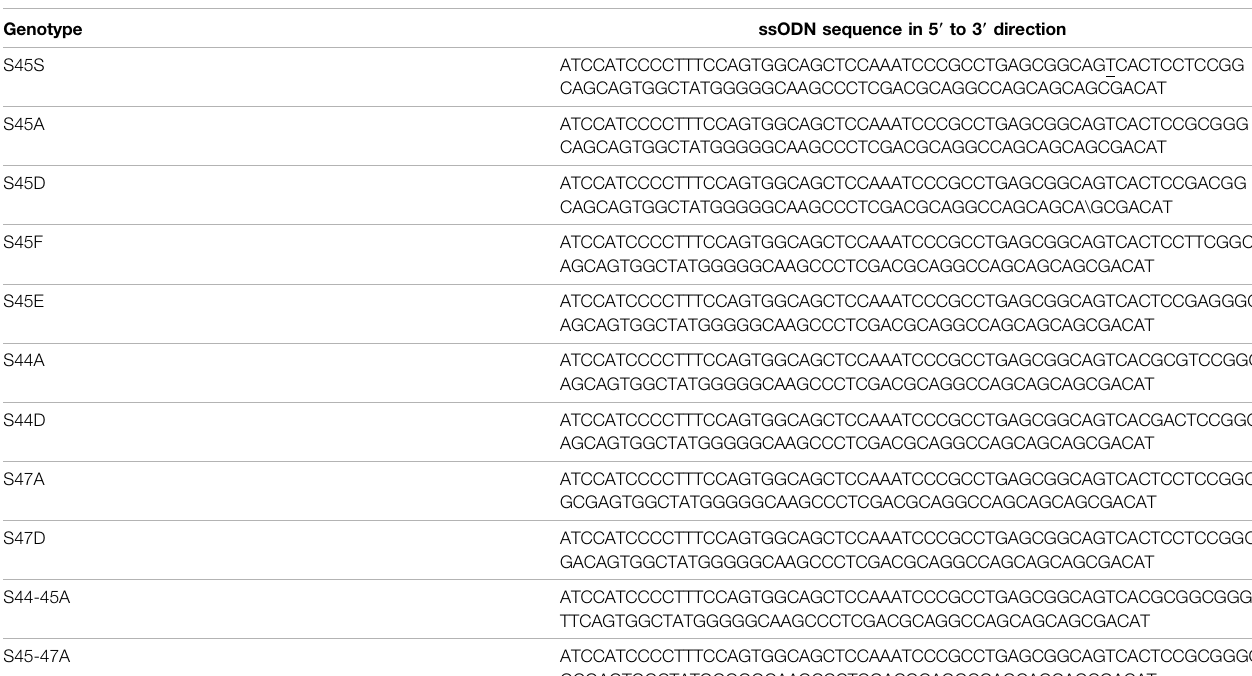
TABLE 2 | ssODNs for per mutagenesis.